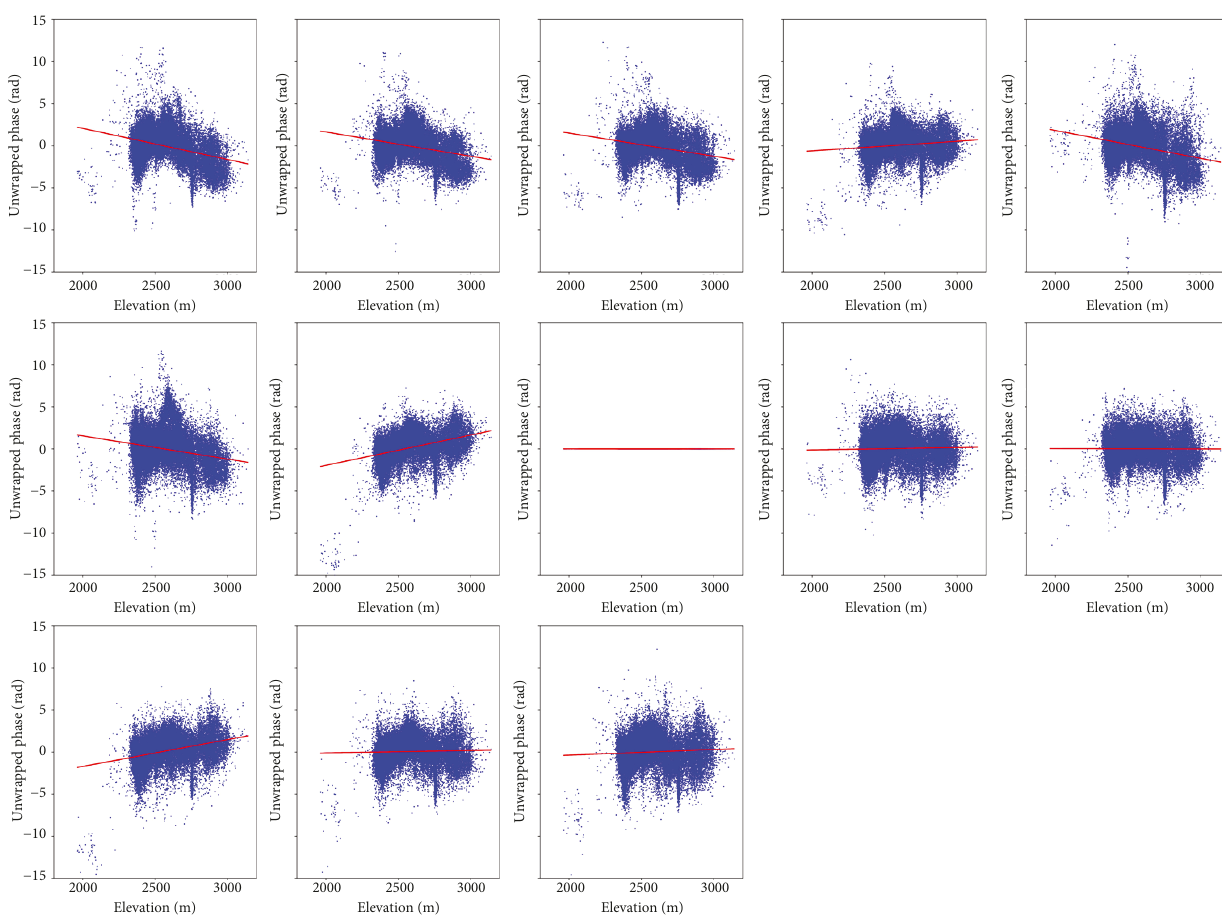
Figure 4: Relationship between elevation and the unwrapped phase for all interferograms. Red lines represent the linear trend used for the corrections of the tropospheric phase delays. The numbering of the interferograms corresponds to the slave images listed